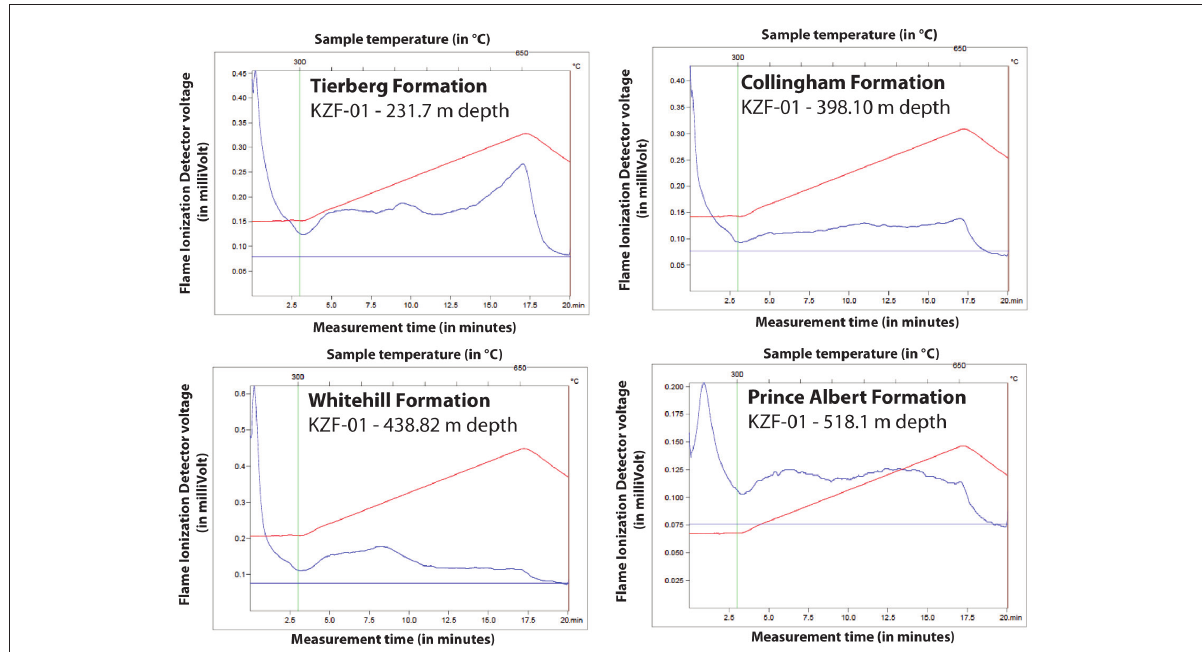
Figure 6: Selected pyrograms obtained of carbonaceous shale samples from